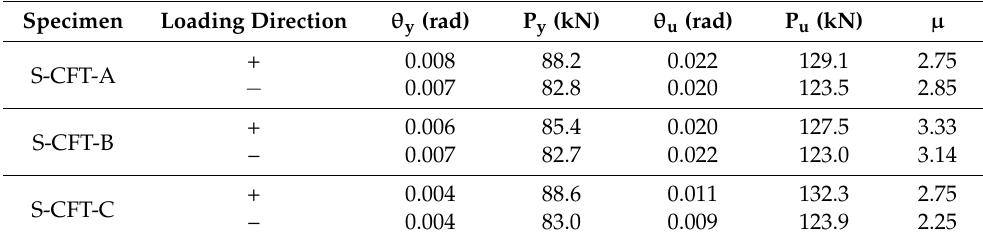
Table 4. Summary of the test results.